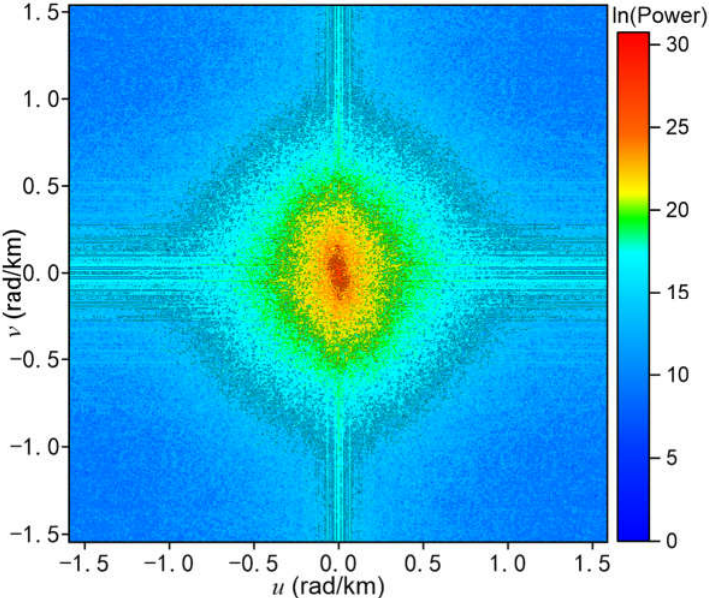
Figure 4. The logarithmic power spectrum of the magnetic anomalies of the SCS.